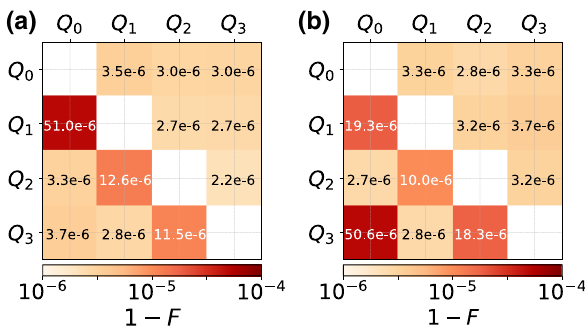
FIG. 6. Gate error of simultaneous single-qubit X gates (i.e., composite gate X ⊗ X ) applied to an arbitrary qubit pair of (a) the four-qubit chain system and (b) the 2 × 2 four-qubit square system shown in Figs. 5(b) and 5(c). Elements in the upper tri- angular part of the error matrix denote ideal composite gate error obtained by adding the errors of constituted isolated gates, and elements in the lower triangular parts correspond to the gate error of simultaneous gate